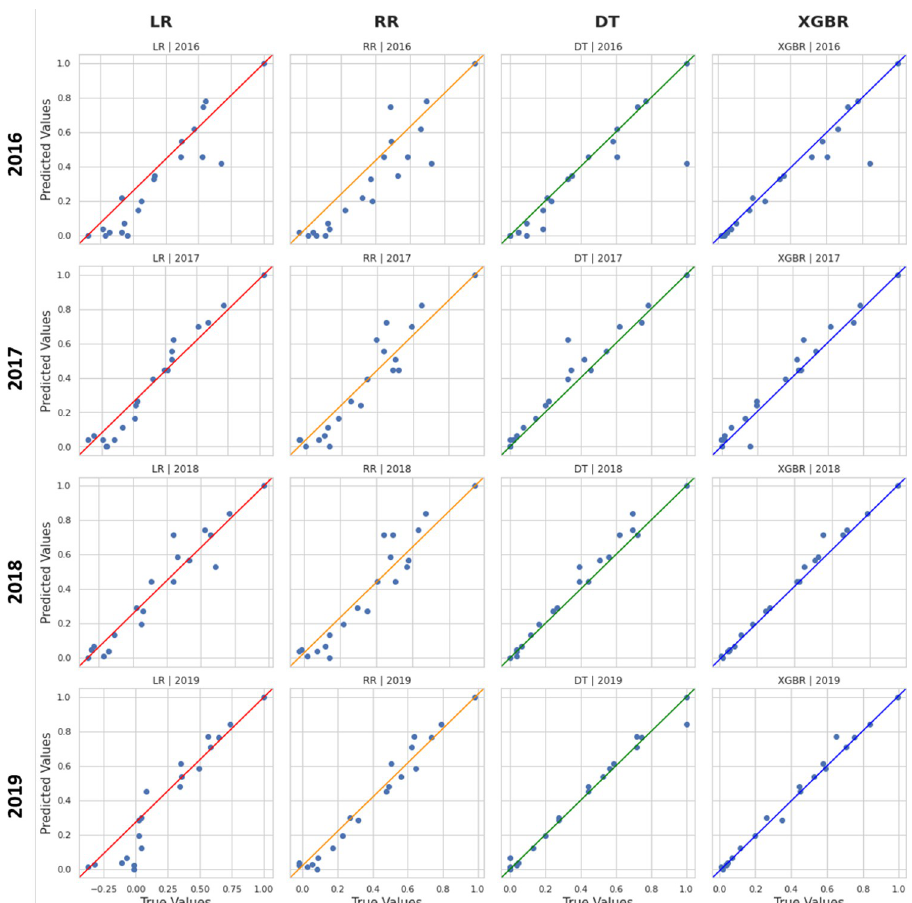
Fig 4. Scatter plots matrix for regional models’ performance. For each scatter plot, the true values are reported on the x-axis, while the predicted ones are reported on the y-axis. The rows of the matrix represent the years, while the columns represent the implemented model: Linear Regression (LR), Ridge Regression (RR), Decision Tree Regressor (DT), Extreme Gradient Boosting Regressor